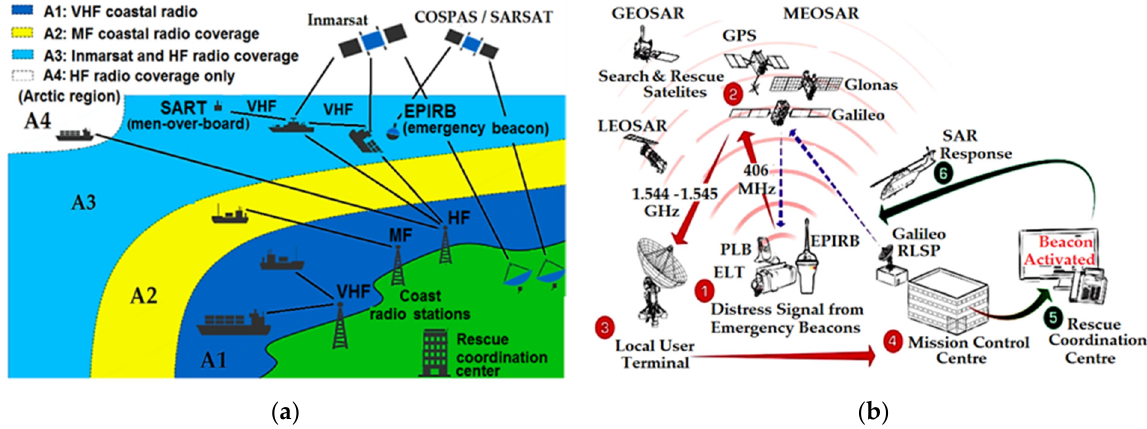
Figure 1. ( a ) Area of the Global Maritime Distress and Safety System (GMDSS) [14]. ( b ) The concept of the Global Satellite System for Search and Rescue [15].